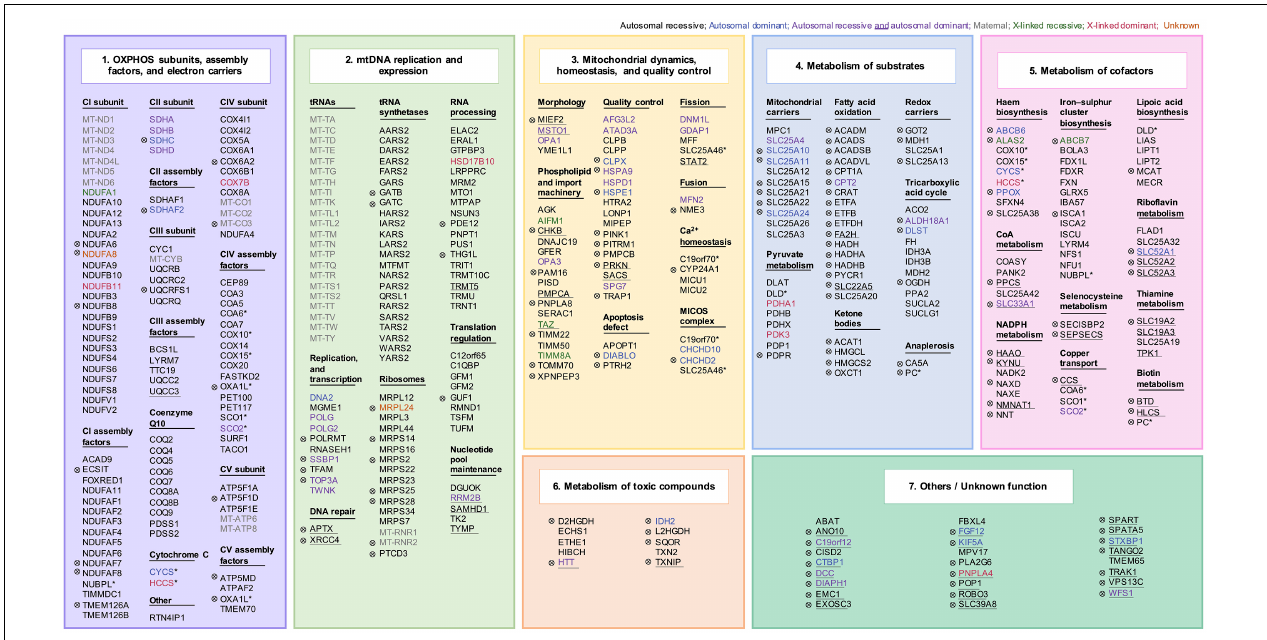
FIGURE 3 | Mitochondrial disease genes. An association with mitochondrial disorders has been reported for 413 genes. Genes were grouped into subcategories according to their function: (1) OXPHOS subunits, assembly factors, and electron carriers (112/413 genes), (2) mitochondrial DNA replication and expression (104/413 genes), (3) mitochondrial dynamics, homeostasis, and quality control (55/413 genes), (4) metabolism of substrates (57/413 genes), (5) metabolism of cofactors (49/413 genes), (6) metabolism of toxic compounds (10/413 genes), and (7) others (26/413 genes). The mode of inheritance is indicated by color. A total of 13 genes have more than one mitochondrial function, indicated by an asterisk. Genes not included in the core set of all four publications (141/413 genes) are indicated by a sign ( ⊗ ). Genes encoding proteins not localized to the mitochondrion according to MitoCarta2.0 are highlighted with an underscore (54/413